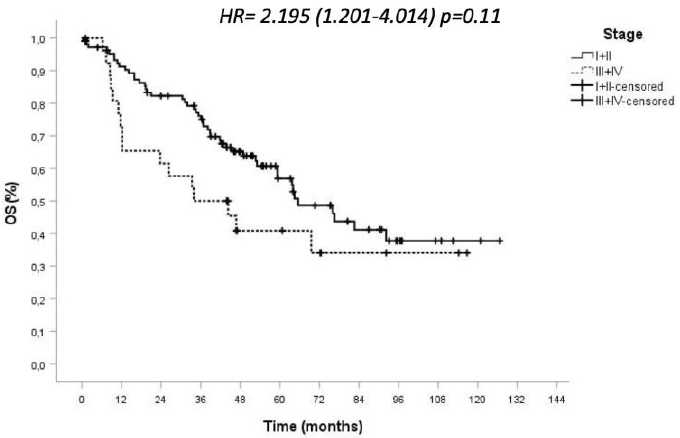
Figure 3. Overall survival of high-risk NSCLC patients according to tumour stage.